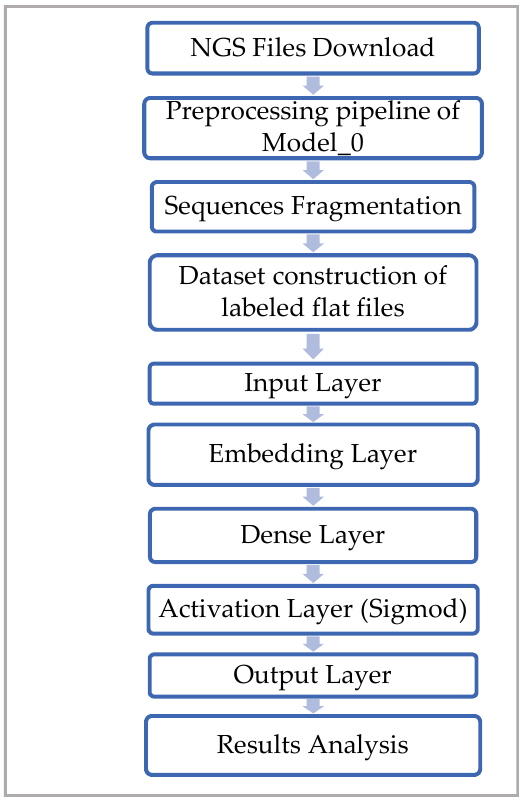
Figure 8. The proposed LSTM model used in miRNA sequences’ analysis (Model_II) .